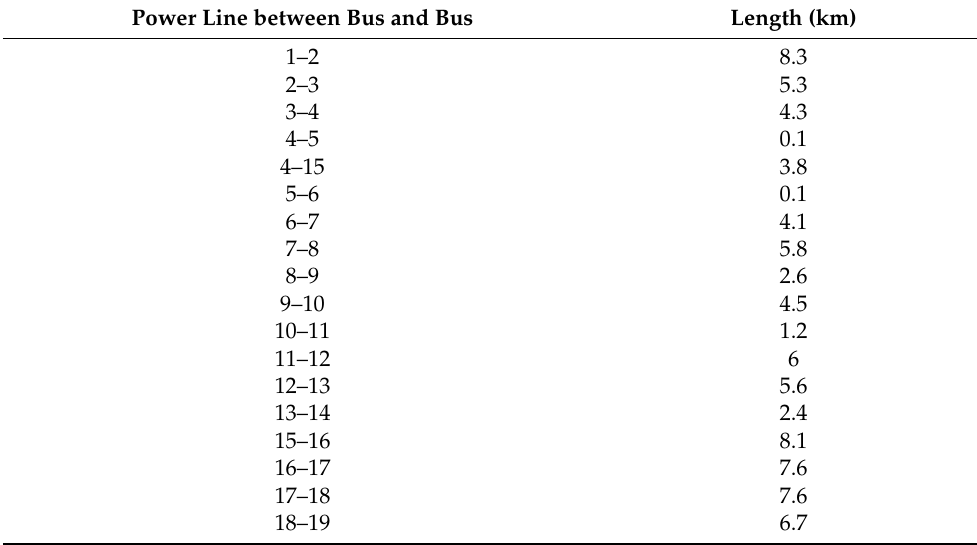
Table 4. Length of the power line between buses.